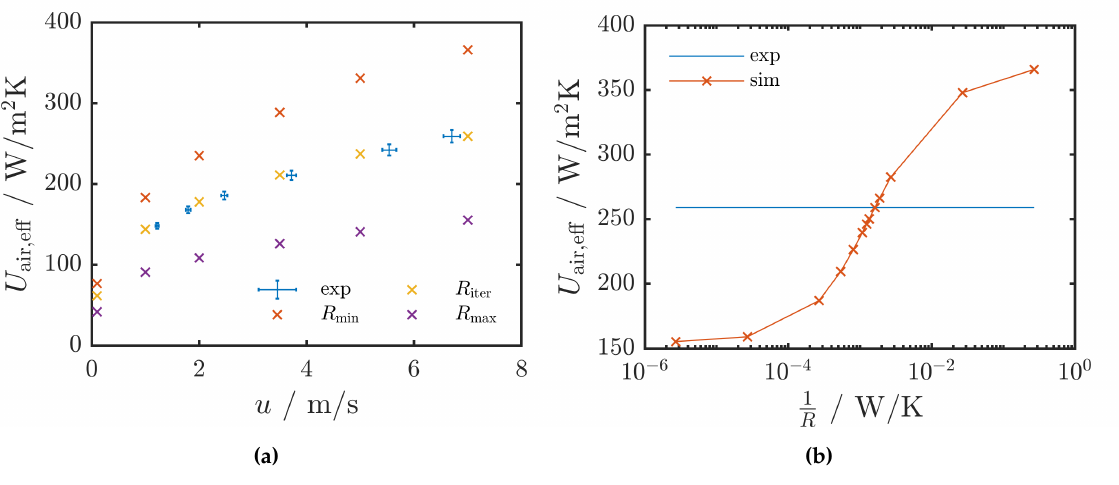
Figure 7. ( a ) Effective heat transfer coefficient U air,eff as a function of inlet velocity u . Experimental results and numerical results with variation of thermal resistance R . ( b ) Predicted and measured heat transfer coefficient U air,eff as a function of reciprocal thermal resistance 1 / R at u =